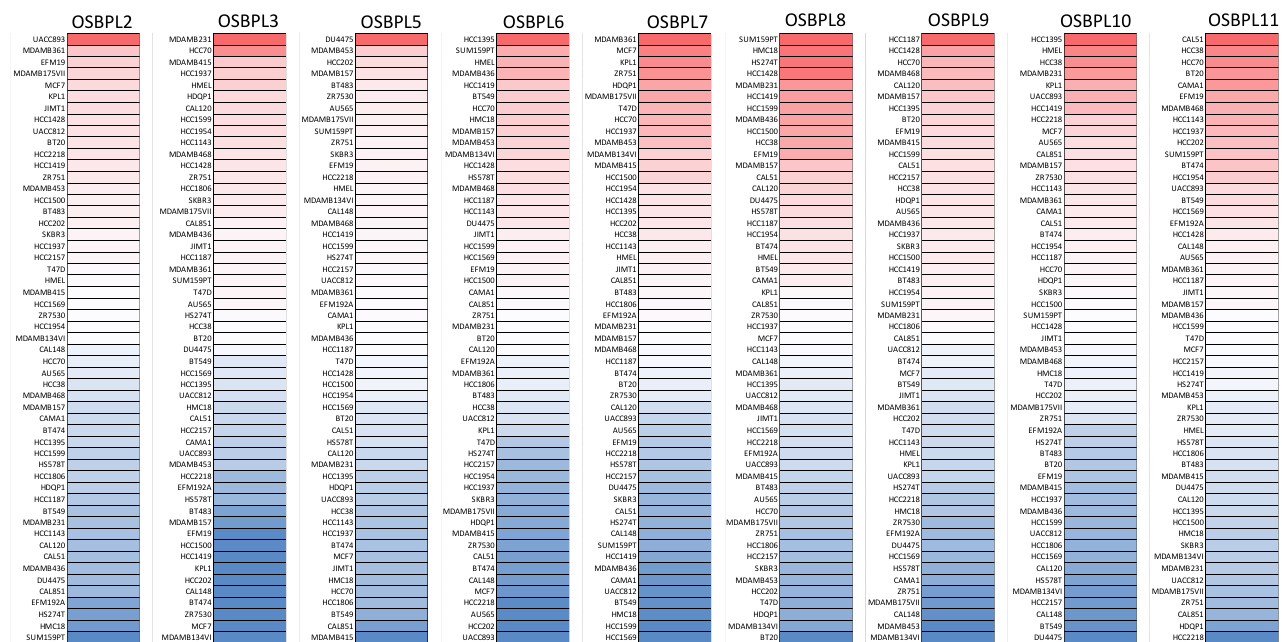
Figure 3. Heatmap plots representing oxysterol-binding protein (OSBP)-like (OSBPL) family gene expression levels in all pancreatic ductal adenocarcinoma (PDAC) cell lines acquired from the CCLE database. The upturned blocks in red indicate overexpression, while the lower blocks in blue indicate underexpression.